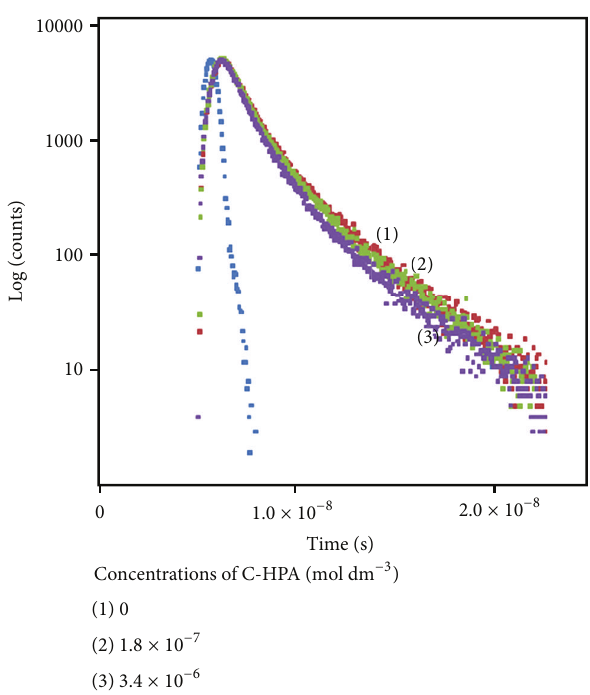
Figure 6: Time-resolved fluorescence spectra of C334 in C-HPA.